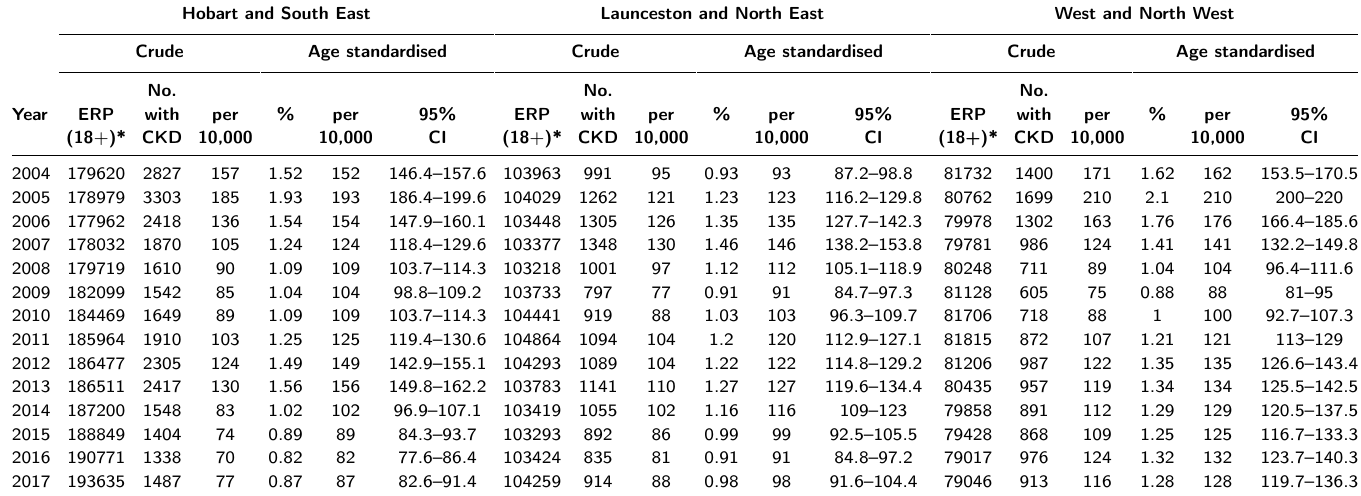
Supplementary table 1: Incidence of chronic kidney disease in Tasmania by geographical region